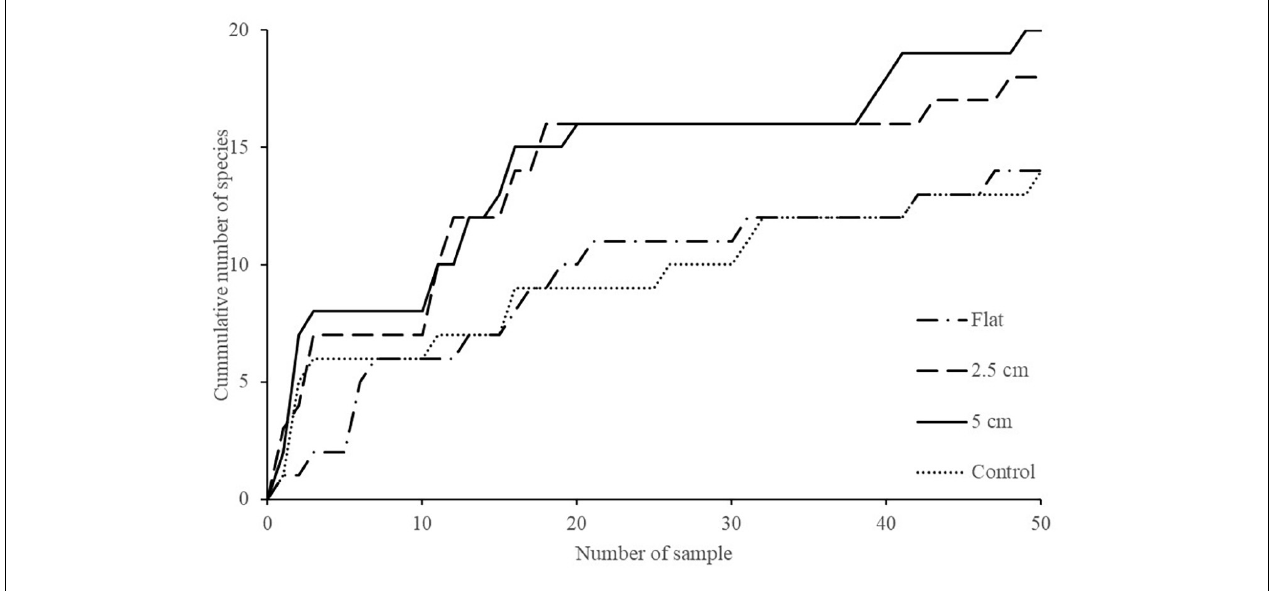
FIGURE 5 | Cumulative number of taxa on flat, 2.5 cm, 5 cm, and control tiles at both sites through time.